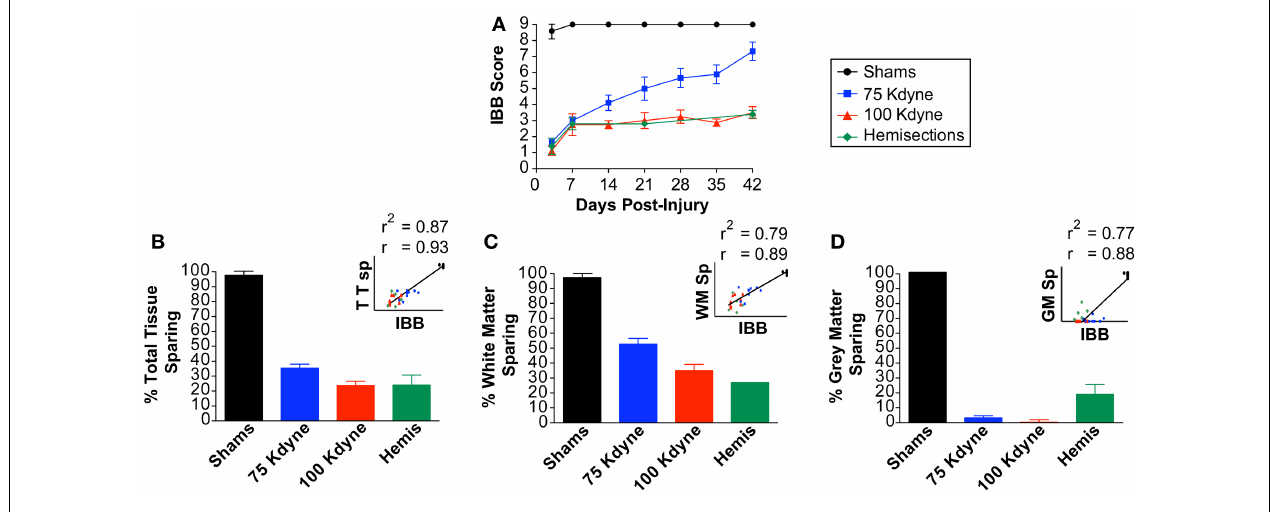
scatterplot and regression line between the IBB (averaged over time) and each of the established tests.The Pearson correlation ( r ) and the shared variance ( r 2 ) appear above each scatterplot; group identity for each point is color coded.